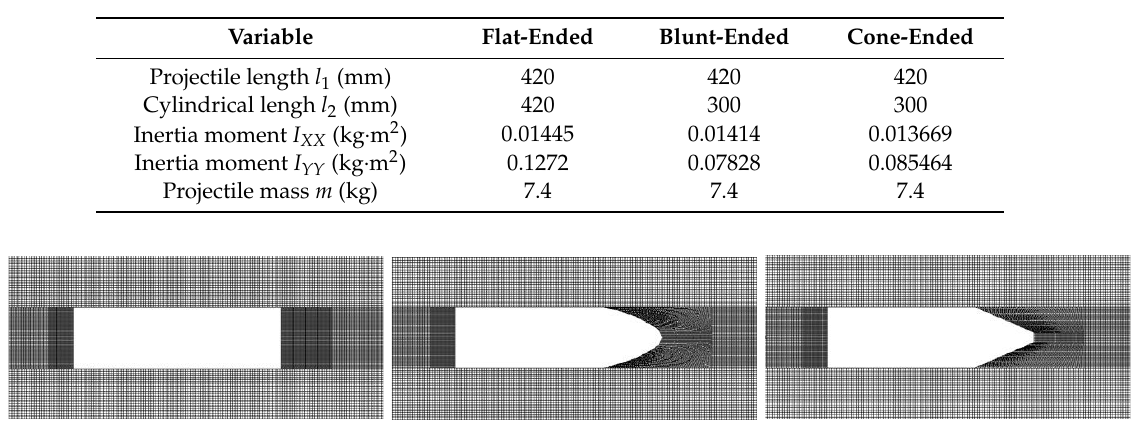
Table 2. Specification of 125 mm shell.